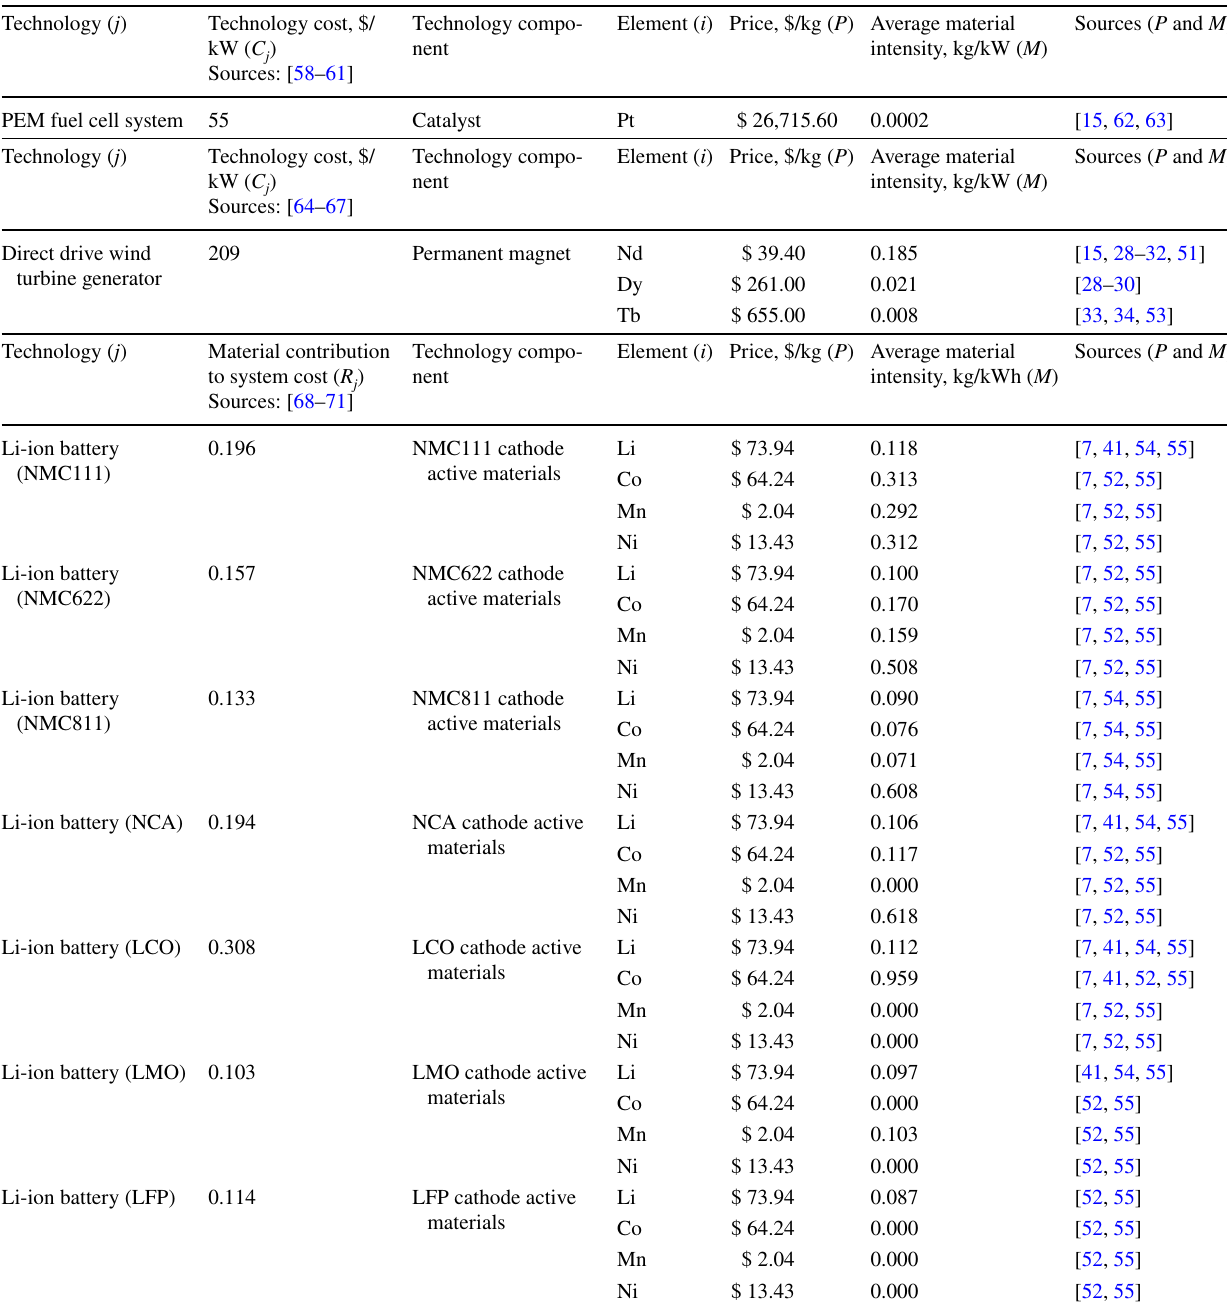
Table 1 Values used for each of the case study clean energy technology’s economic calculations